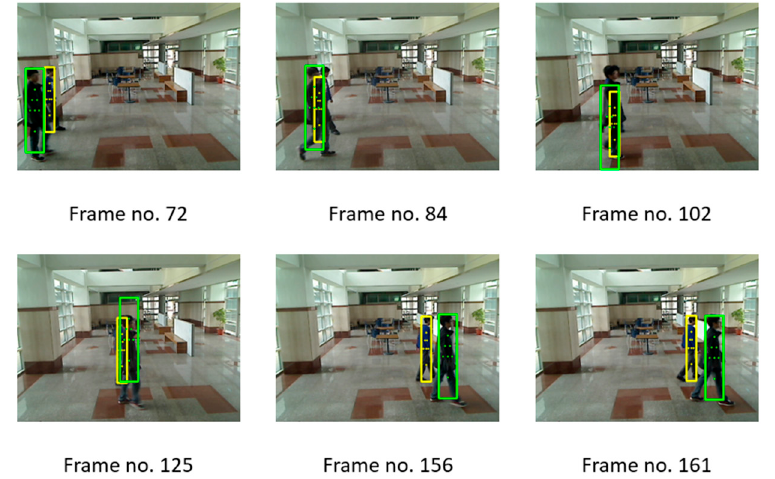
Figure 20. MS metrics ( left ) FIT metrics ( right ) for two persons tracking in overlapping scene ( a ) person 1; ( b ) person 2.